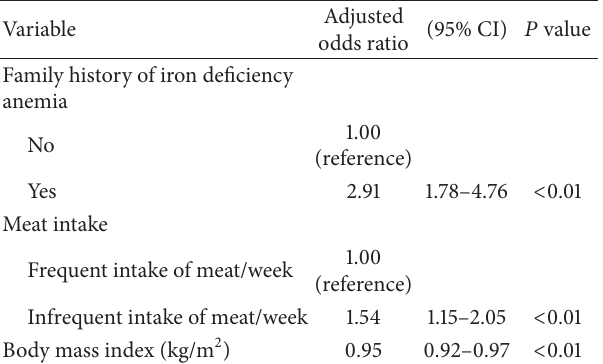
Table 4: Multivariate logistic regression showing adjusted odds ratio between family history of iron deficiency anemia, infrequent intake of meat, and body mass index with anemia in child bearing age women in Riyadh, Saudi